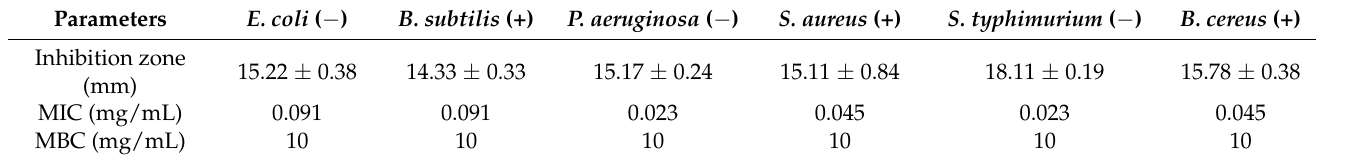
Table 2. Antibacterial activity of